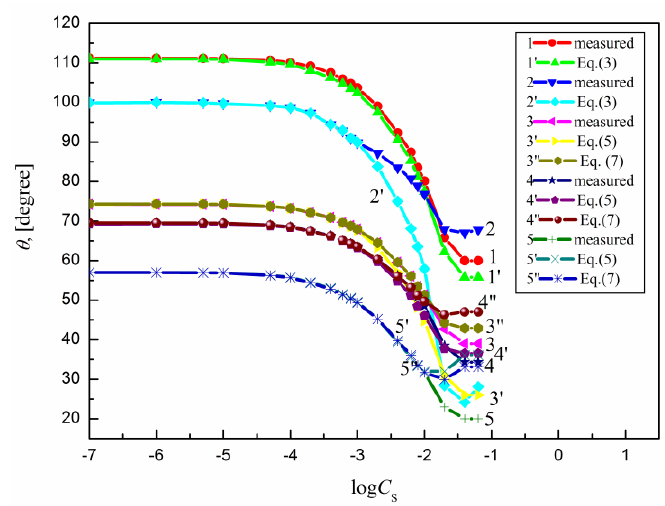
Figure 1. A plot of the contact angle ( θ ) of the aqueous solution of OGP on the PTFE (curves 1 and 1′), PE (curves 2 and 2′), PMMA (curves 3, 3′ and 3′′), nylon 6 (curves 4, 4′ and 4′′) and quartz (curves 5, 5′ and 5′′) against the logarithm of OGP concentration ( S C ). Curves 1–5—the measured θ values, curves 1′ and 2′—the values calculated from Equation (3), curves 3′, 4′ and 5′—the values calculated from Equation (5) and curves 3′′, 4′′ and 5′′—the values calculated from Equation (7).